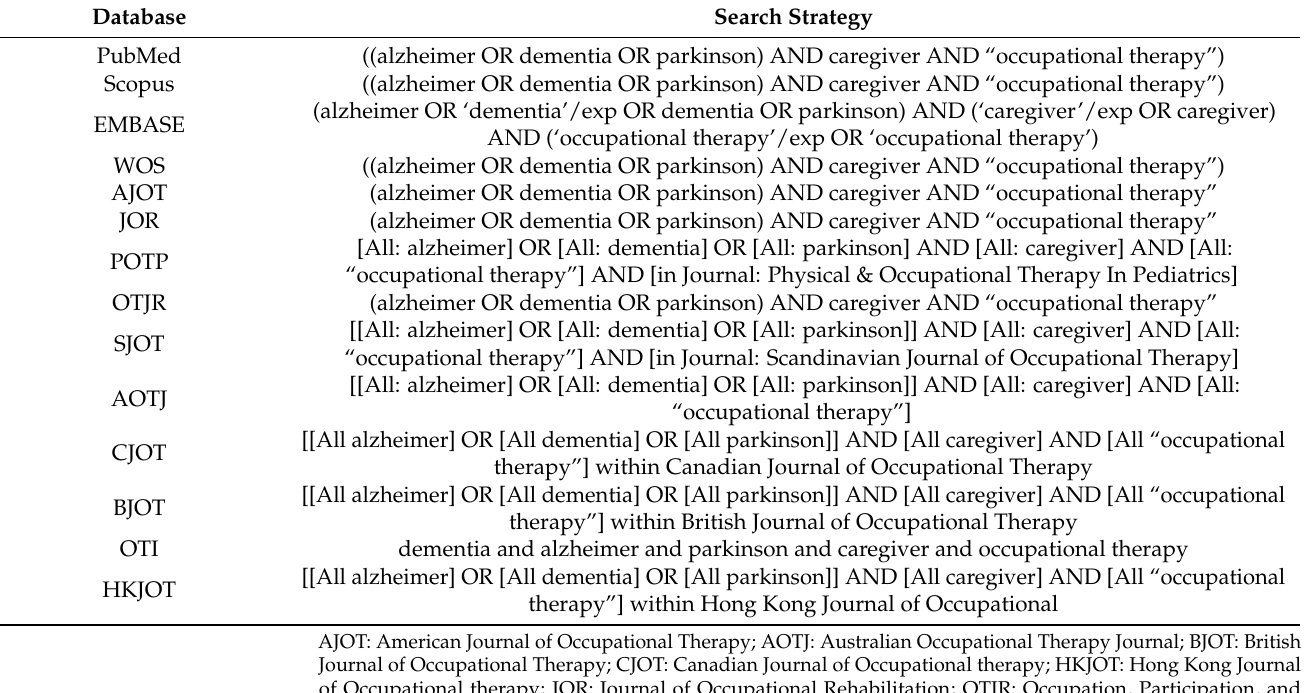
Table 1. Search strategies and